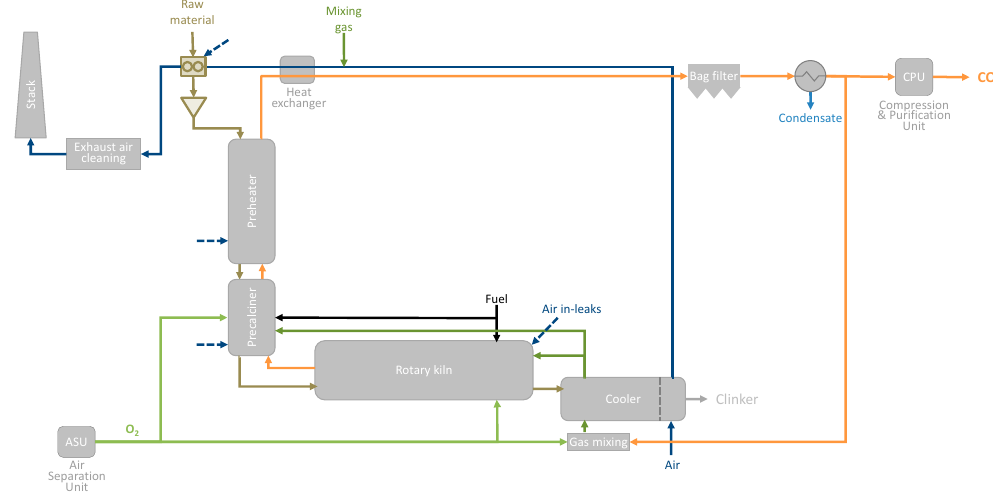
Figure 14. Configuration of an oxyfuel cement plant (adapted from [77]).